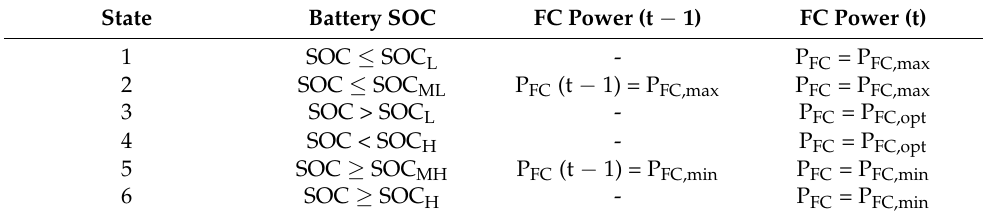
Table 4. Control rules of the state machine control.